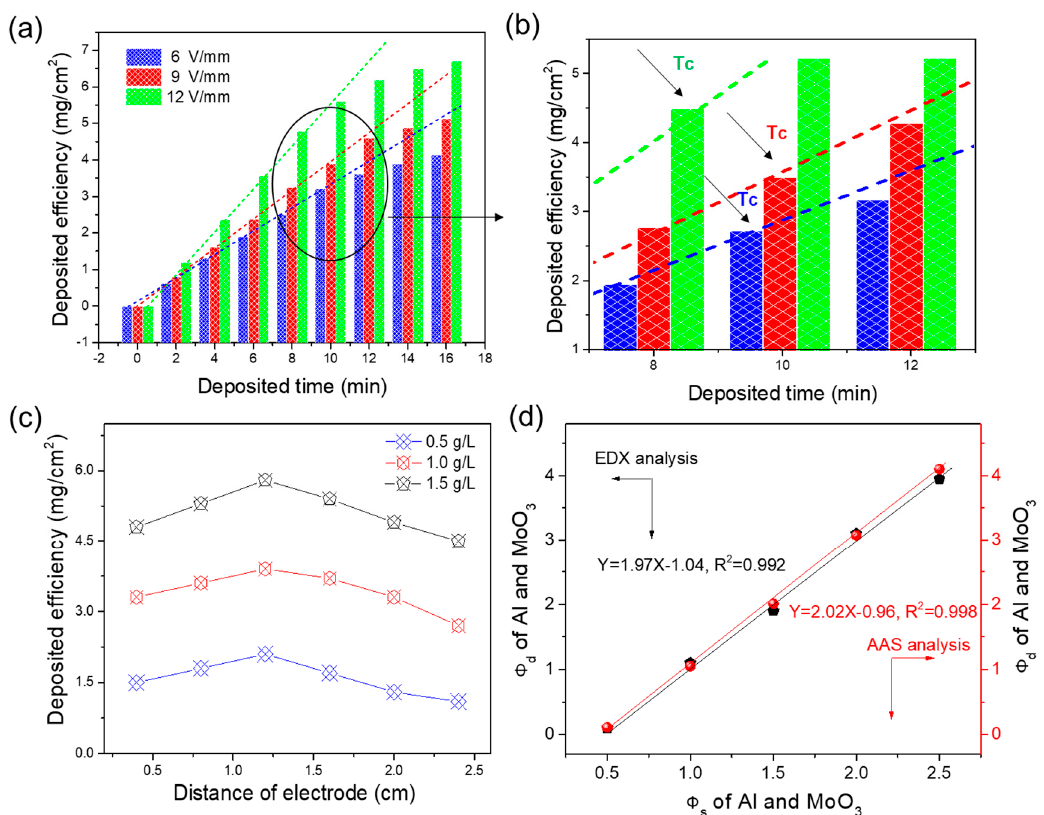
Figure 2. ( a ) Deposited e ffi ciency (mg / cm 2 ) of nano-Al / MoO 3 MIC as functions of deposition time under di ff erent applied electric field strengths; ( b ) the local amplification image of the black circle in ( a ); ( c ) the relationship of deposited e ffi ciency and the distance of two electrodes under di ff erent loading concentrations; and ( d ) Φ d of Al and MoO 3 in the Al / MoO 3 MIC chip as a function of Φ s of nano-Al and MoO 3 particles in the starting suspension.